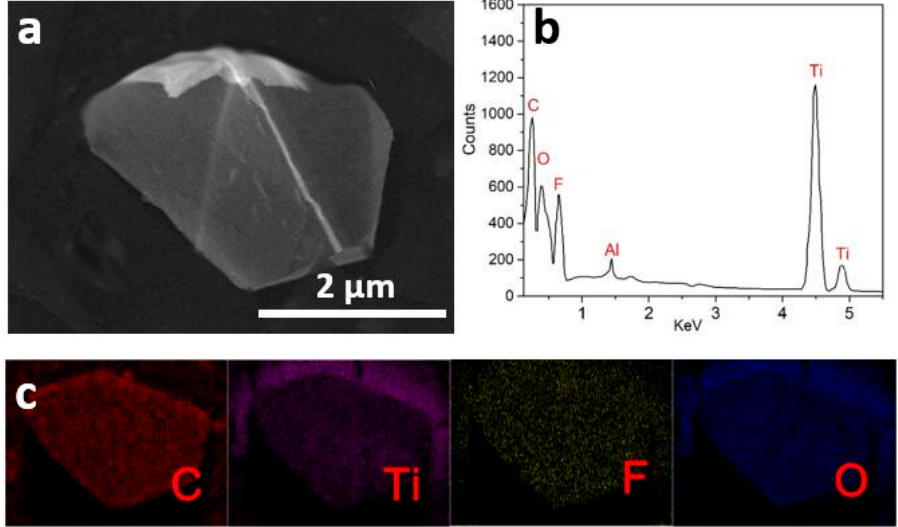
Figure 3. ( a ) SEM image of Ti 3 C 2 T x nanosheets, ( b ) energy-dispersive X-ray spectroscopy (EDX) spectrum of Ti 3 C 2 T x nanosheets, and ( c ) element mappings of Ti 3 C 2 T x nanosheets. Table 1. Element content of Ti 3 C 2 T x MXene nanosheets. Element Atomic